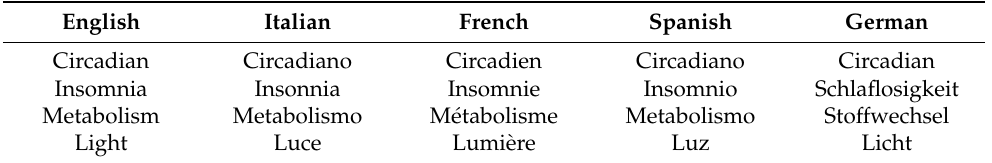
Table 1. Translated searched terms 1 . English